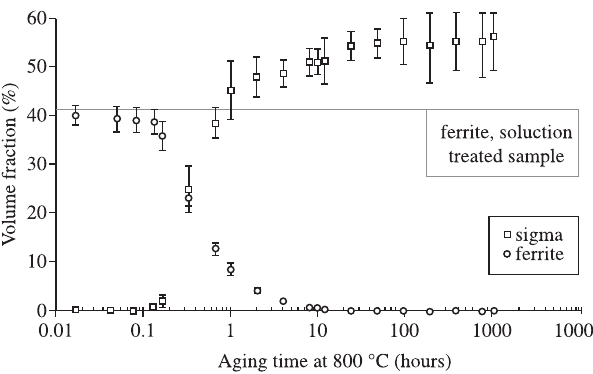
Figure 5. Ferrite and sigma phase content (vol%) as a function of aging time at 800 °C.